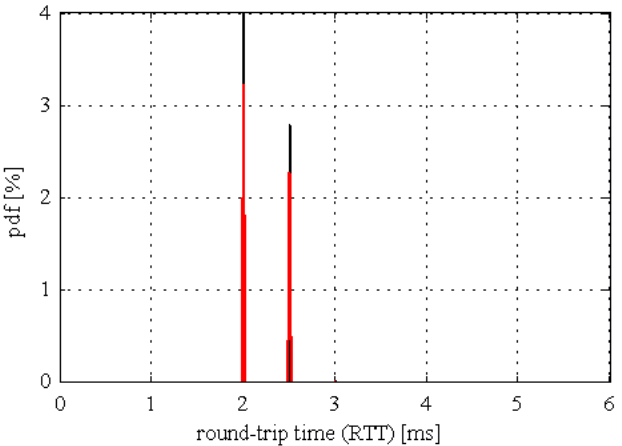
Figure 4. Round-trip time for local distributed XIL (Ilmenau